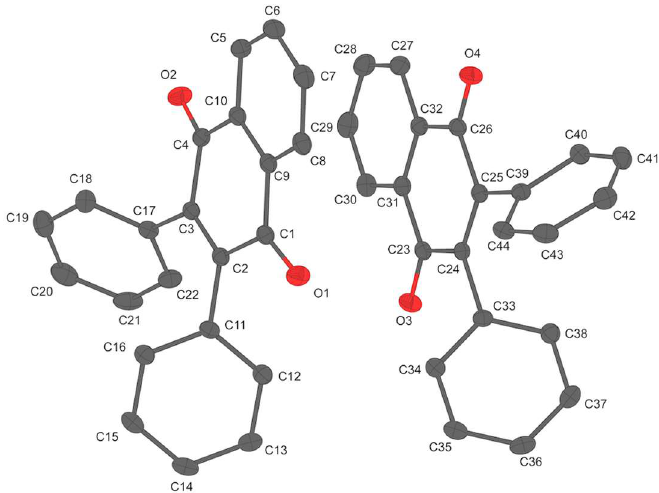
Figure 4. Molecular structure of the phenyl nqDAE 5 asymmetric unit with thermal ellipsoids drawn at the 50% probability level. Hydrogen atoms are omitted for clarity.